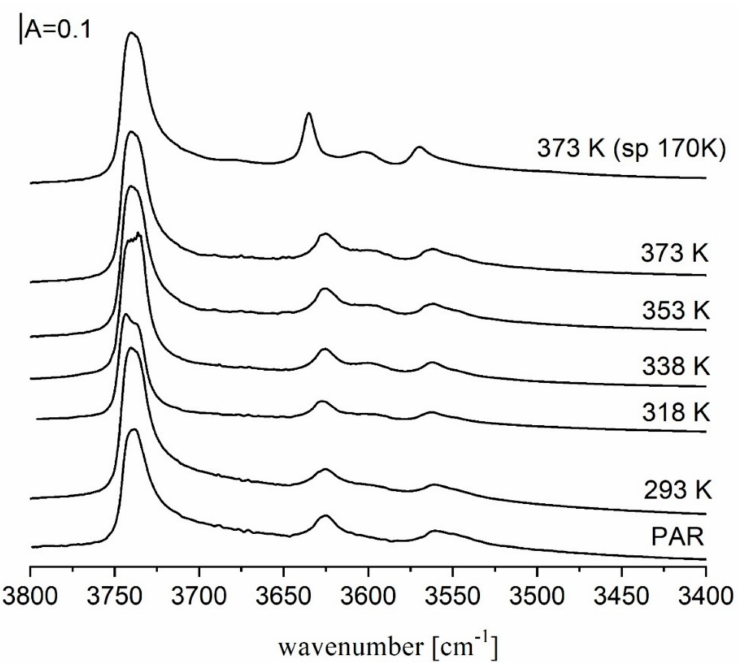
Figure 4. IR spectra of OH groups in zeolite Y desilicated in NaOH / TBAOH at various temperatures. All the spectra were recorded at room temperature, only the top spectrum was recorded at 170 K. Figure adapted with the permission from